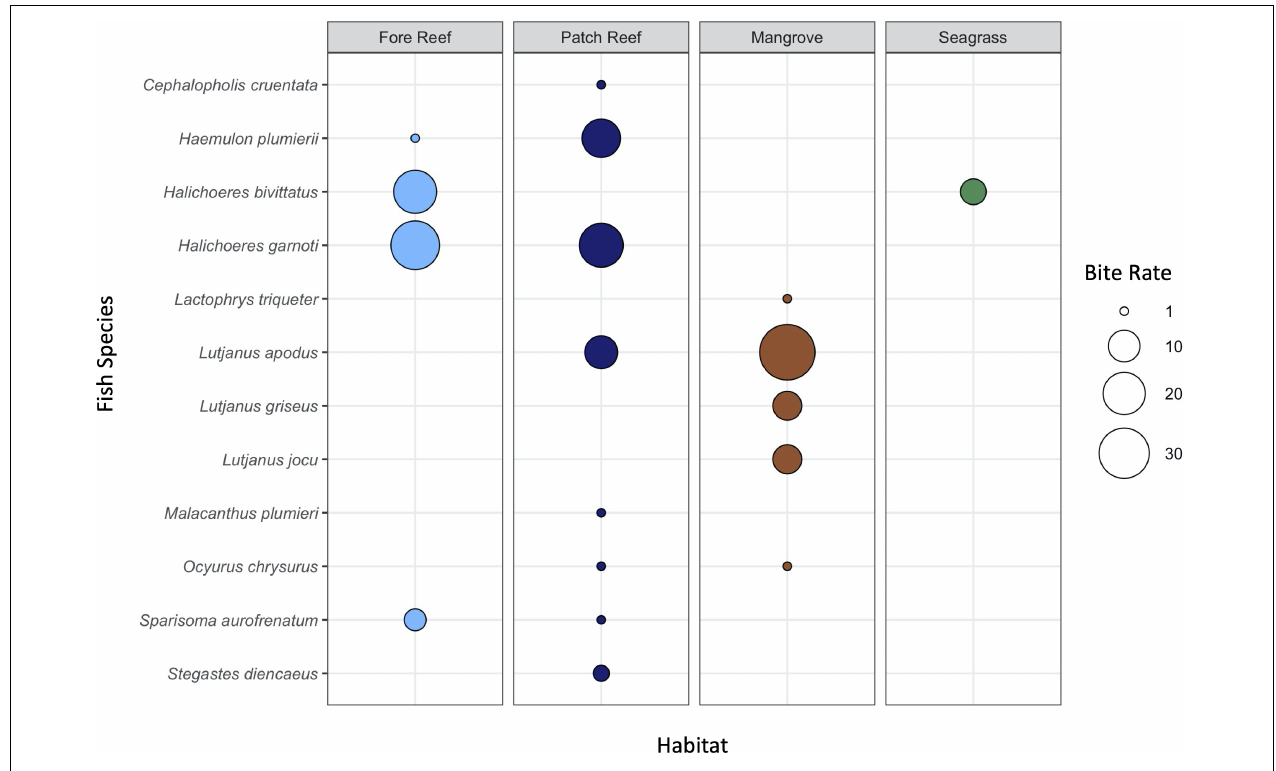
FIGURE 7 | Total number of squid baits consumed by each fish species observed on video in 2017. The size of the point is scaled by the total number of bites across all species and colored by